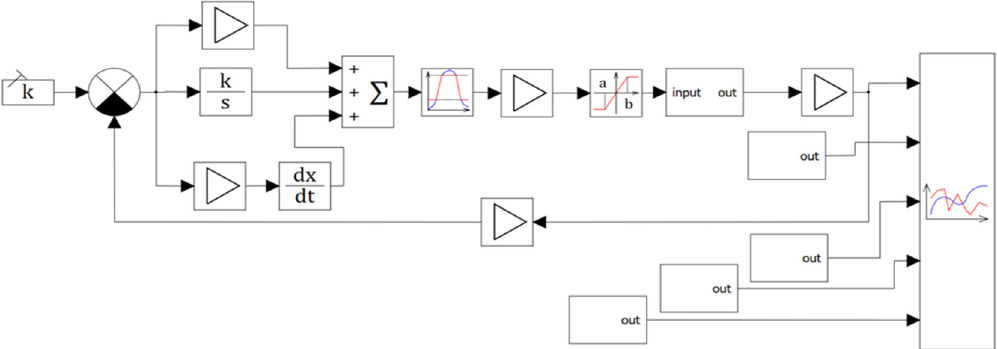
Figure 8. Schematic window with optimized continuous model of the motion module and its continuous-discrete models with different values of quantization period T , placed in blocks Submodel.